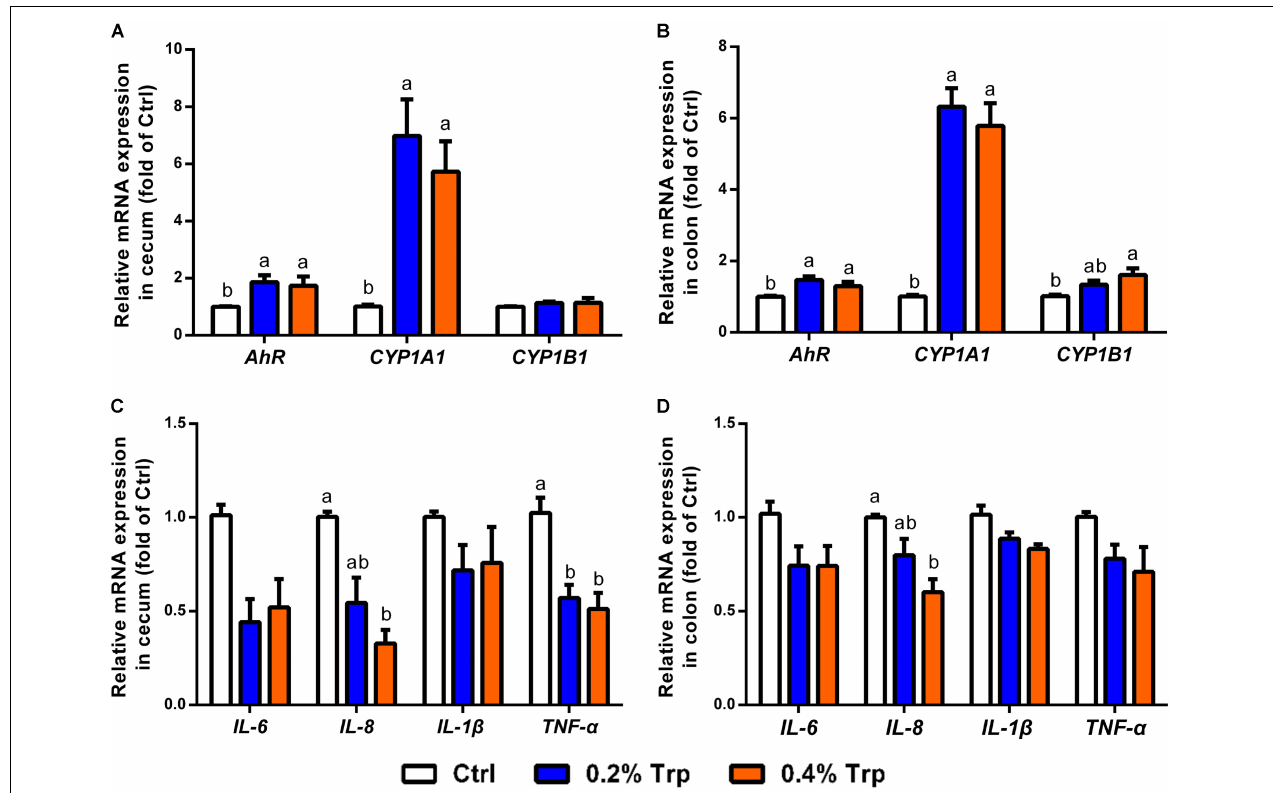
FIGURE 5 | Dietary Trp supplementation influenced AhR activation and immune response in the cecum and colon of weaned pigs. The mRNA levels for AhR , CYP1A1 and CYP1B1 in cecal (A) and colonic (B) tissues. The mRNA levels for IL-6 , IL-8 , IL-1 β and TNF- α are shown for cecal (C) and colonic (D) tissues. Values are means ± SEMs, n = 6. Means without a common letter differ, P <